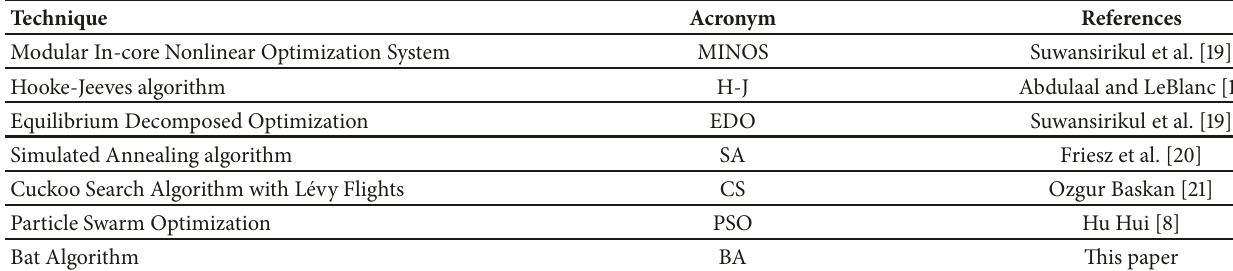
Table 3: Techniques and references of the test case 2.